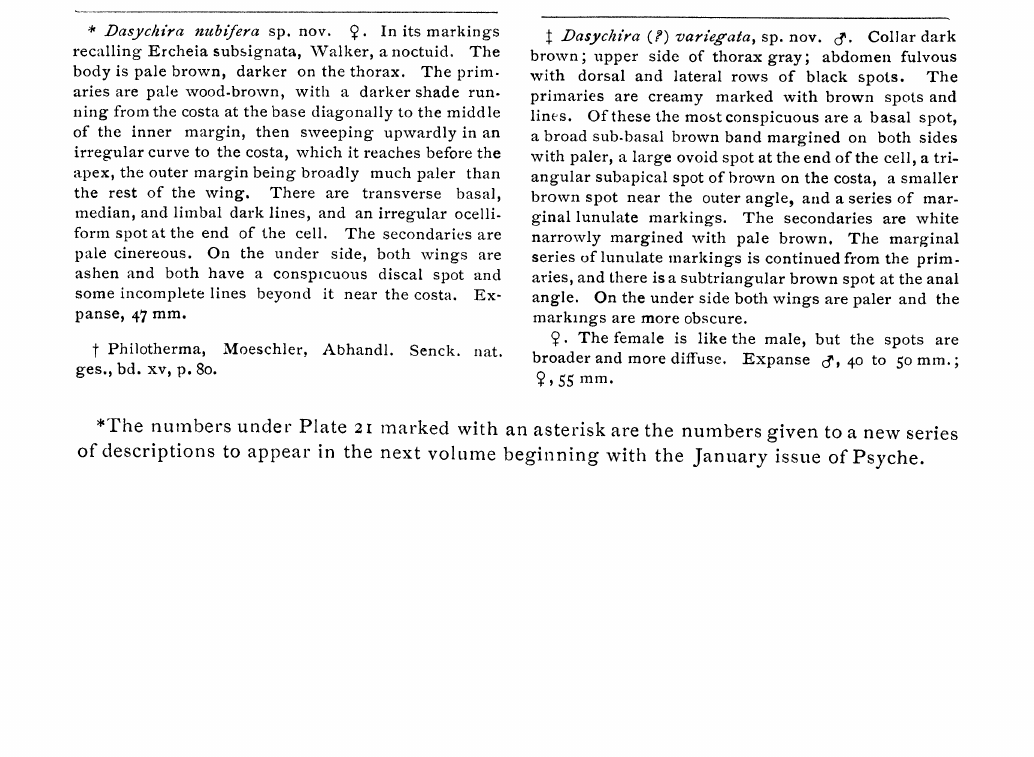
Fig. I. Methorasa cornu-copiae, sp. nov. ()* 2.